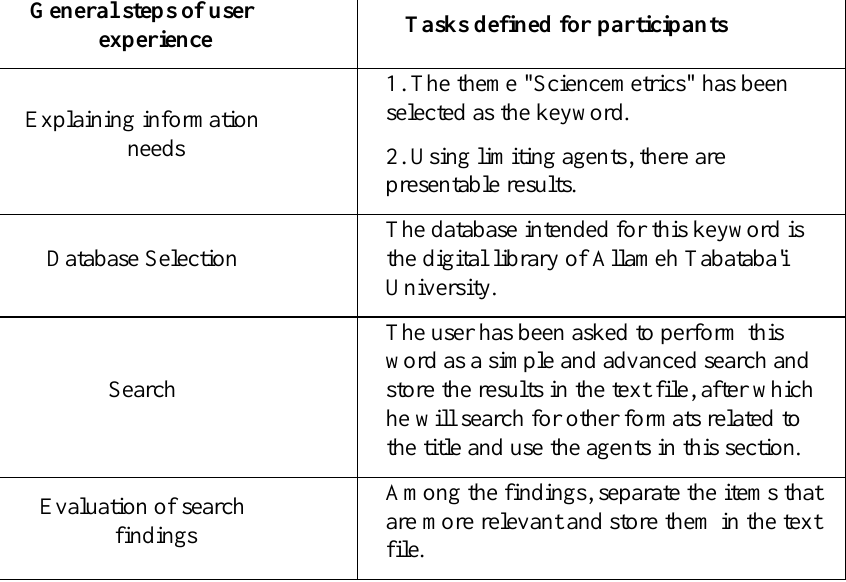
Table 1 Defined Tasks for Research Participants Based on The Overall Stages of User Experience General steps of user Tasks defined for participants experience 1. The theme "Sciencemetrics" has been selected as the keyword. presentable